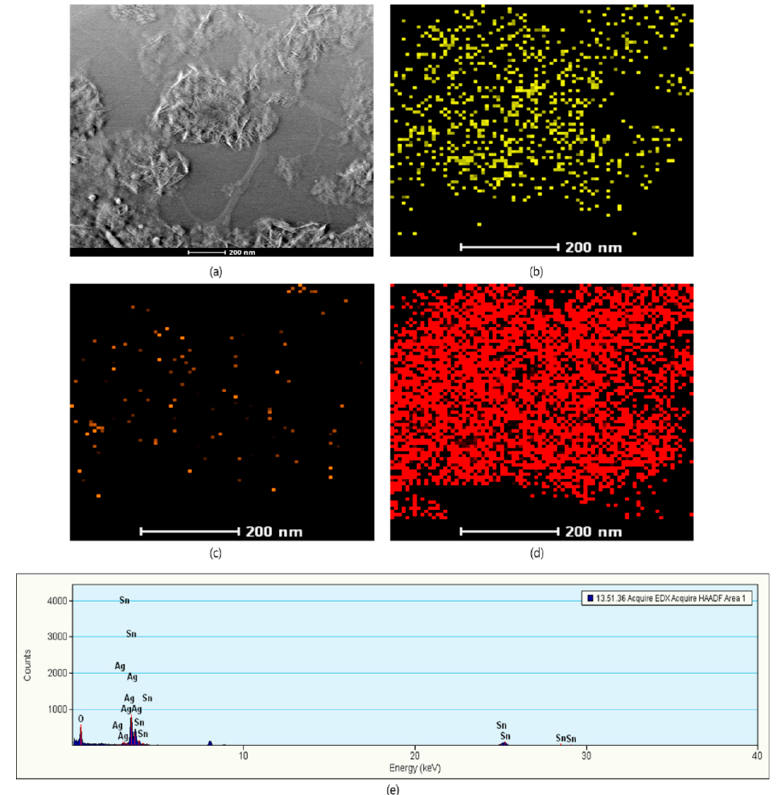
Figure 5. High-angle annular dark-field imaging (HAADF) and elemental mapping of Ag QDs/SnO 2 nanostructures: ( a ) HAADF image; ( b ) Tin; ( c ) Silver;( d ) Oxygen; ( e ) EDX spectrum of Ag QDs/SnO 2 nanostructures.